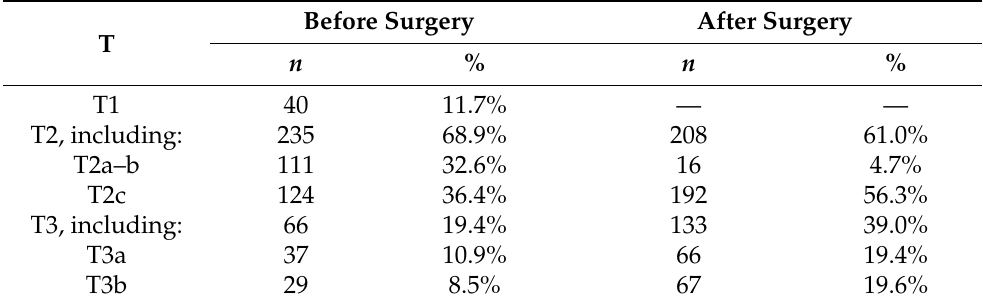
Table 1. Distribution of patients by the volume of prostate tumor lesions by biopsy (T) and after surgery